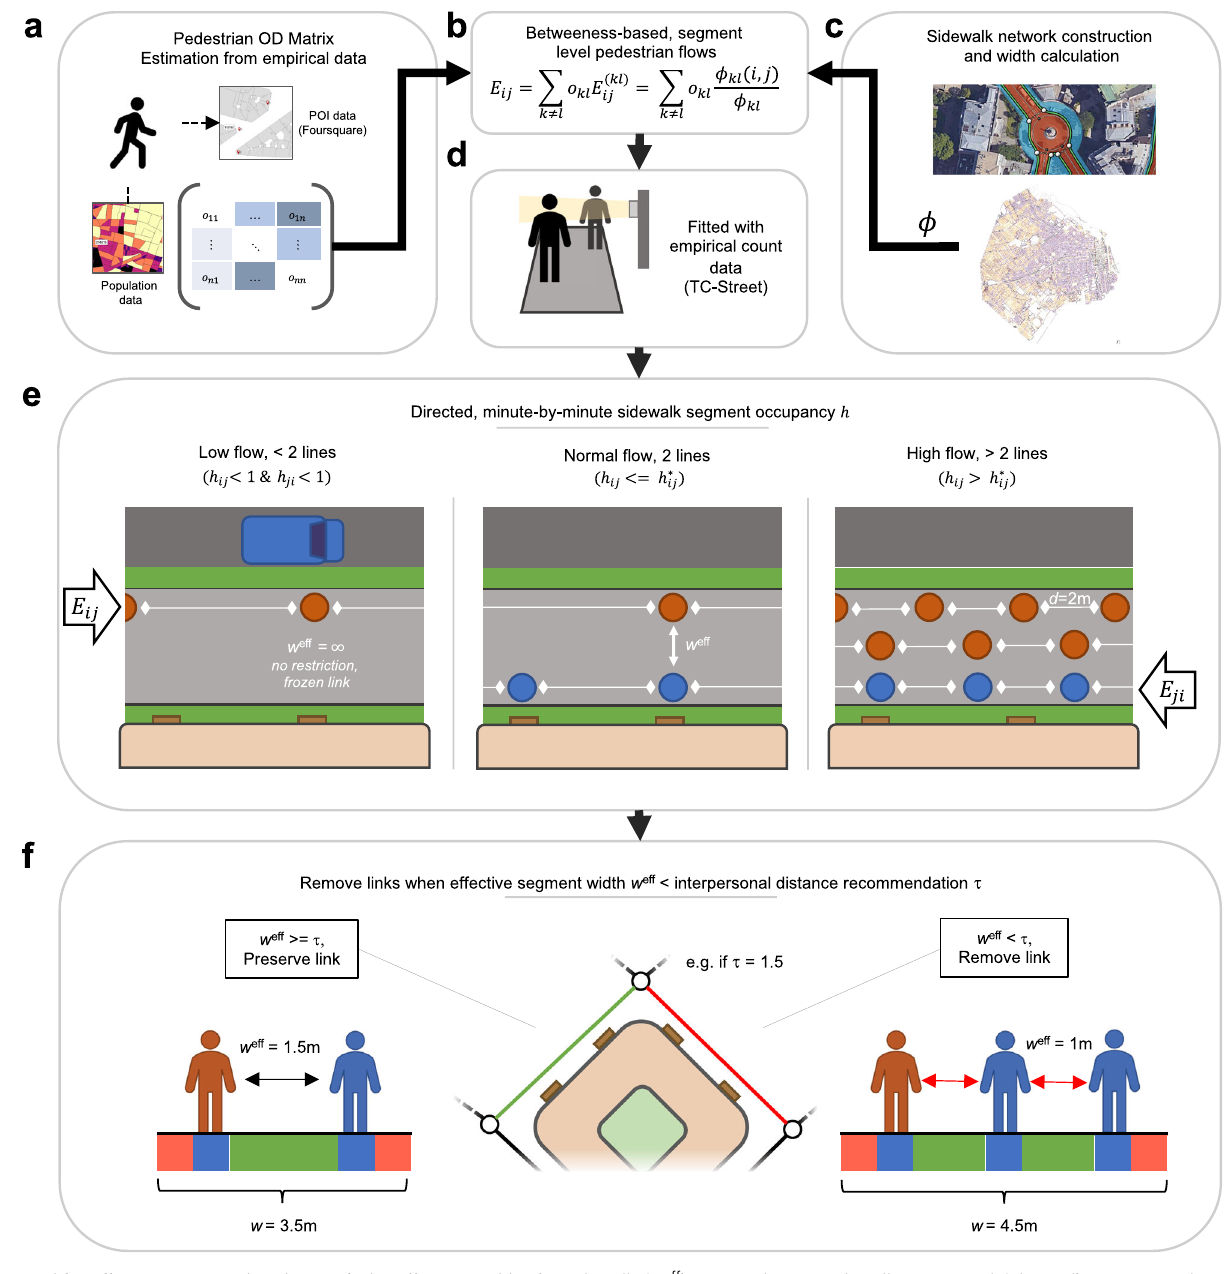
Fig. 2 Sidewalk occupancy estimation. a – d The effective width of a sidewalk ( w eff ) encapsulates a sidewalk ’ s structural (physical) aspects, and its dynamical performance in terms of pedestrian traf fi c. The dynamical aspects are estimated with a number of steps that include ( a ) demographic and service-location (POI: points-of-interest) aspects (pedestrian origin-destination matrix), ( b ) edge betweenness-based ( E ij ) pedestrian fl ow, and ( d ) empirical calibration from actual sidewalk occupancy data. The physical attributes ( c ) are those related with the sidewalk network construction and Geographic Information Systems (GIS) operations involved (see Supplementary Note 1), from which shortest path counts ϕ can be obtained. e This pipeline results in the simpli fi ed consideration of a number of walking lines (pedestrians are represented as orange and blue dots), which determine, given the raw width of a sidewalk, how much space between lines is available ( w eff ). f In turn, w eff is the attribute guiding the percolation protocol. In the example, the segment on the left allows 1.5 m between pedestrians, and is not removed (green); on the contrary, the segment on the right can only guarantee w eff = 1m, and for τ = 1.5 it will be removed (red color). Maps in ( a ) derived from municipal open data sources (see Supplementary Table 1). Imagery in ( c ) courtesy of: Google, © 2021 Aerodata International Surveys, CNES /Airbus, Maxar Technologies. Street networks in ( c ) courtesy of OpenStreetMap